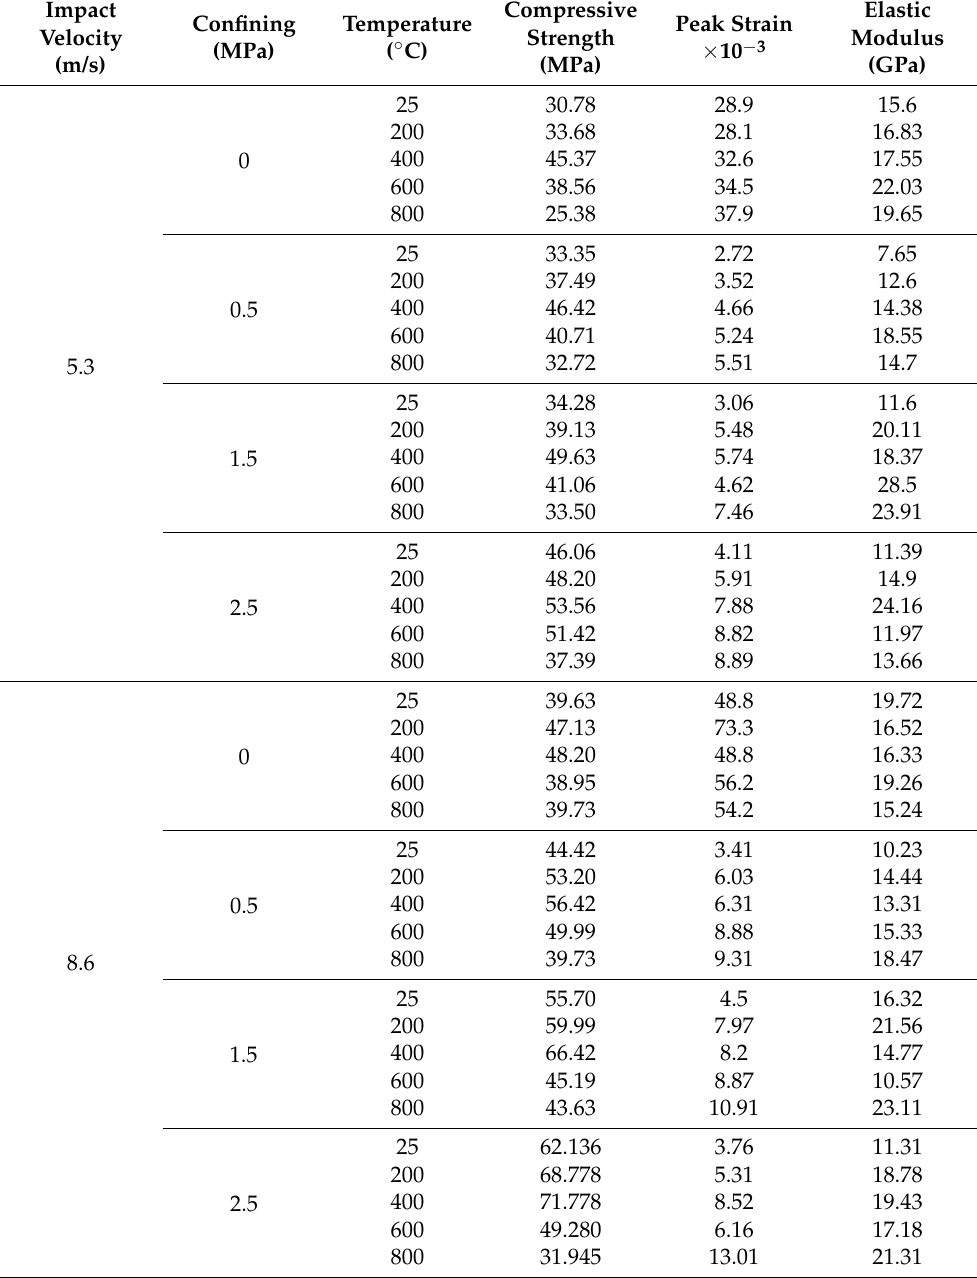
Table 1. Mechanical properties of limestone under dynamic impact